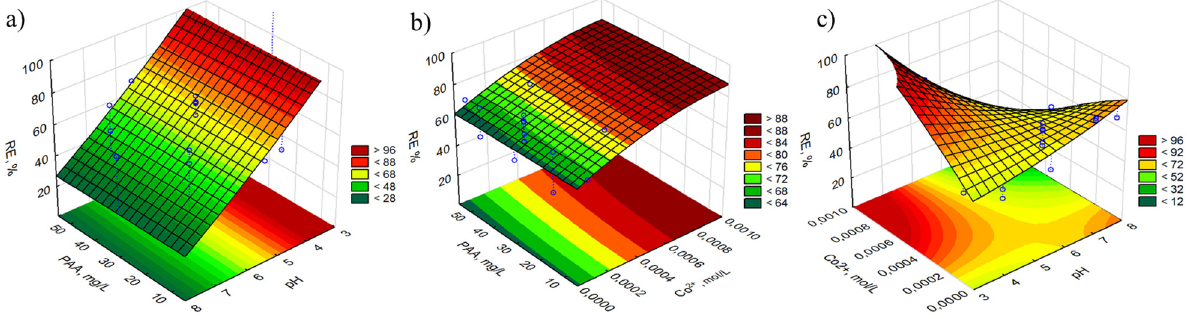
Figure 3. Response surface plots of RE%, as the function of two independent variables: ( a ) C PAA and pH, ( b ) C PAA and C Co2+ , and ( c ) C Co2+ and pH. Conditions: [PAA] 0 = 40 mg/L, [Co 2+ ] 0 = 8 × 10 − 4 mol/L, pH = 4.5.